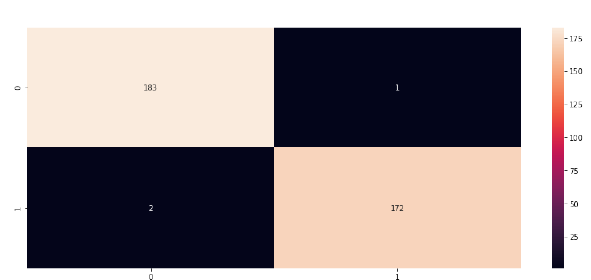
Figure 8. Confusion matrix for gender recognition system